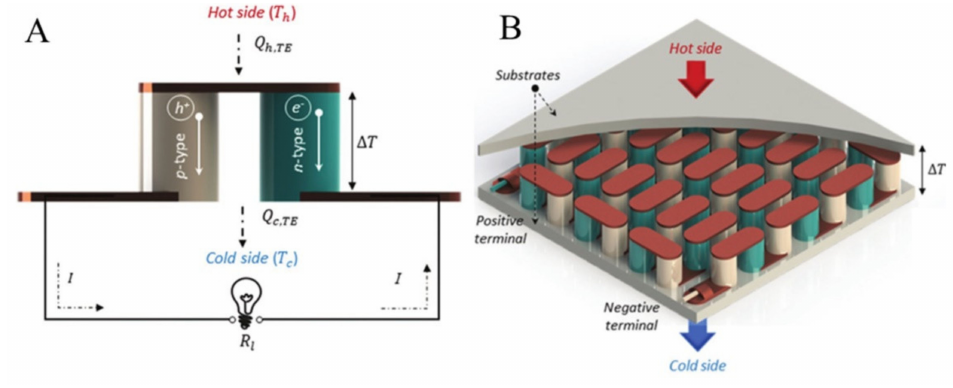
Figure 2. Schematic diagrams of the ( A ) Seebeck effect [22]. ( B ) TEG module [22]. A typical TEG module consists of pairs of π -type TE legs connected in series, as shown in Figure 2B. Based on the Seebeck effect, each pair of π -type TE legs consists of the p-type and n-type semiconductors fixed in series between two insulating substrates. When a heat source of temperature T h is applied onto one side of the TEG, and another side of the TEG is exposed to a low temperature ( T c ) environment, a temperature difference ( ∆ T ) is created between the TE pair. Therefore, most of the charge carriers generated at p-type (holes) TE legs and n-type (electrons) TE legs move from the higher to the lower temperature side, which generates an open-circuit voltage ( V oc ) across these TE pairs [33,34]. The electrical